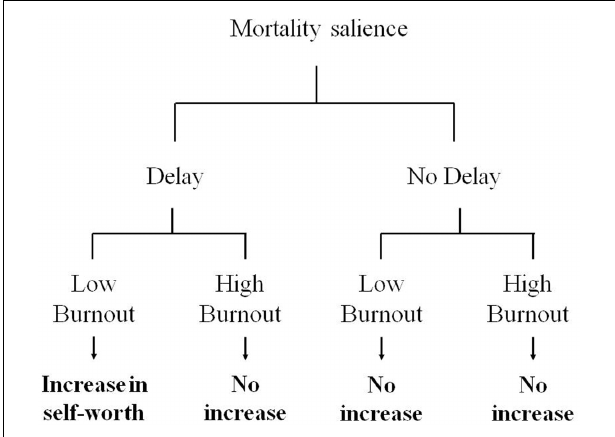
FIGURE 1 | The hypothesized three-way interaction between mortality salience (MS), delay, and